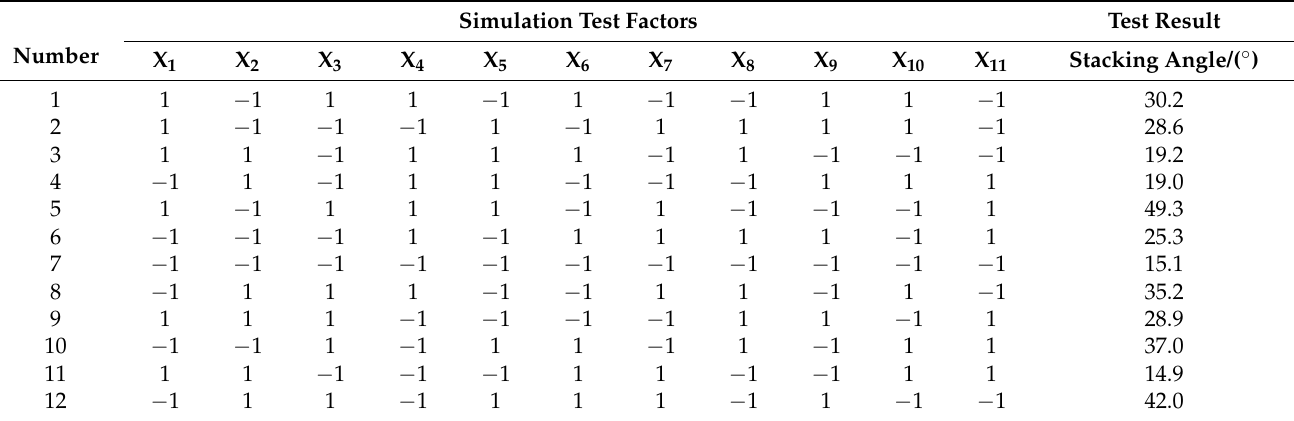
Table 3. Design and results of the Plackett–Burman test.